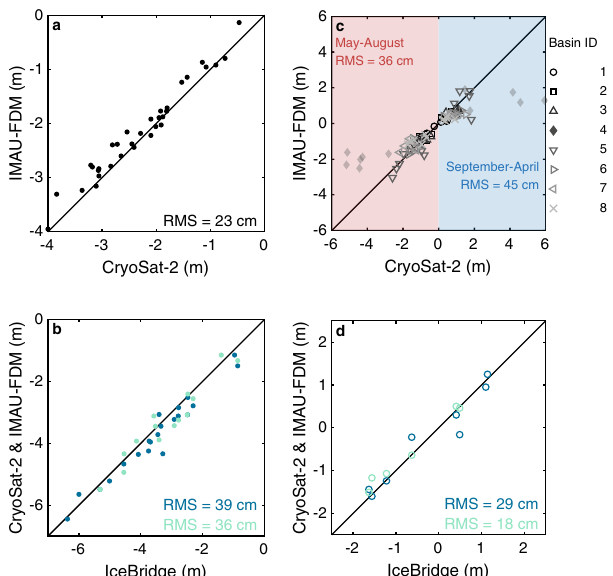
Fig. 3 Surface height evolution and seasonal elevation changes in the ablation zone of the Greenland Ice Sheet from CryoSat-2 altimetry, fi rn modelling and airborne laser altimetry. a Institute for Marine and Atmospheric Research Utrecht Firn Densi fi cation Model (IMAU-FDM) versus CryoSat-2 60-day estimates of height evolution in the ice sheet ablation zone between 2011 and 2016. b CryoSat-2 (dark blue) and IMAU- FDM (light blue) height evolution versus Operation IceBridge laser altimeter measurements 38 between 2011 and 2018 acquired in sectors 6.2 and 7.2 (Fig. 2). c IMAU-FDM versus CryoSat-2 summer and winter elevation changes in the ice sheet ablation zone between 2011 and 2017 and in 7 principal ice sheet drainage basins 39 . For completeness, we include Basin 4 here, but exclude it from our reported statistics, because the ablation zone there is narrow (<1 % of its total extent), and has a rugged terrain that is challenging for both altimetry and regional climate modelling. d CryoSat-2 (dark blue) and IMAU-FDM (light blue) versus Operation IceBridge seasonal elevation changes between 2015 and 2018 in sectors 6.2 and 7.2 (Fig. 2). In each panel, the root mean square difference (RMS) between the respective datasets is